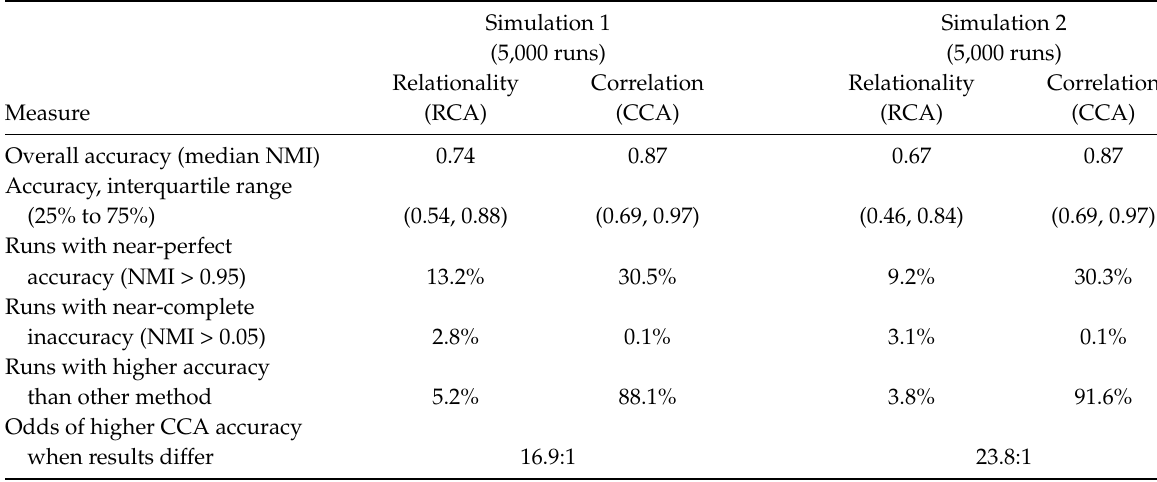
Table 1: Comparison of RCA and CCA accuracy in 10,000 simulation